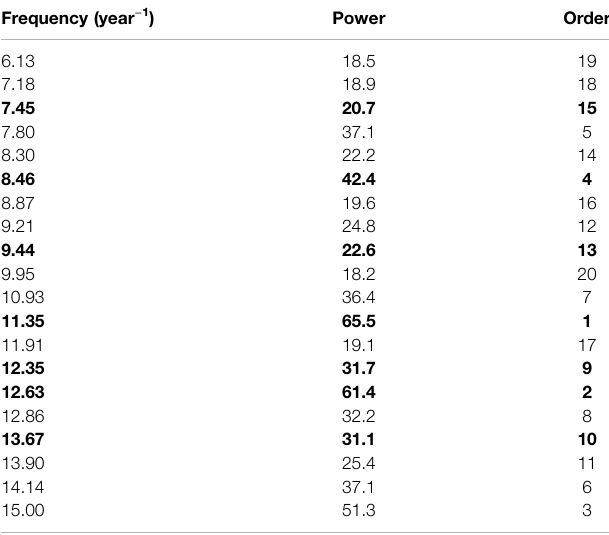
Bold represents that three pairs of frequencies separated by 1 year − 1